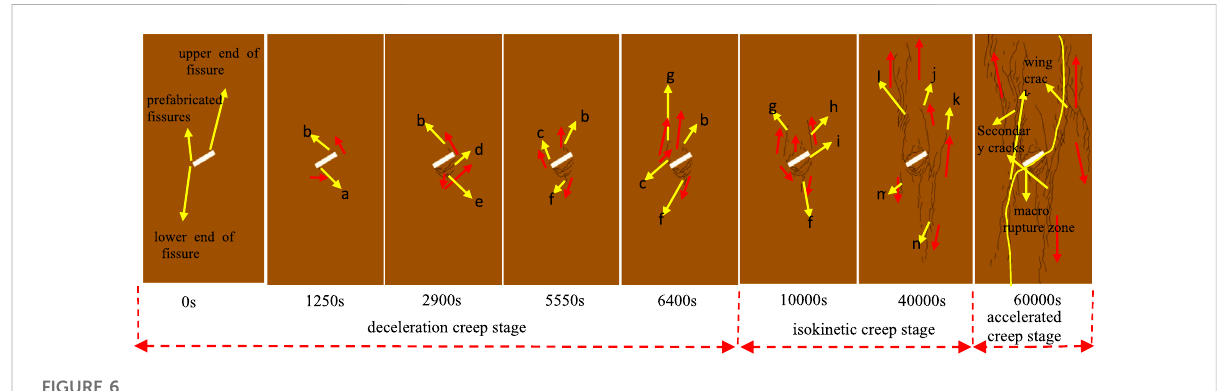
FIGURE 6 Creep rupture crack propagation in a rock mass with a single